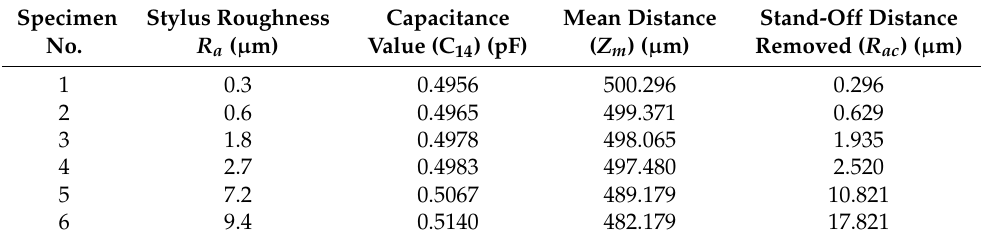
Table 5. Stylus- vs. capacitance sensor (5.6 mm sensing diameter)-measured roughness (single-shot measurement)—software